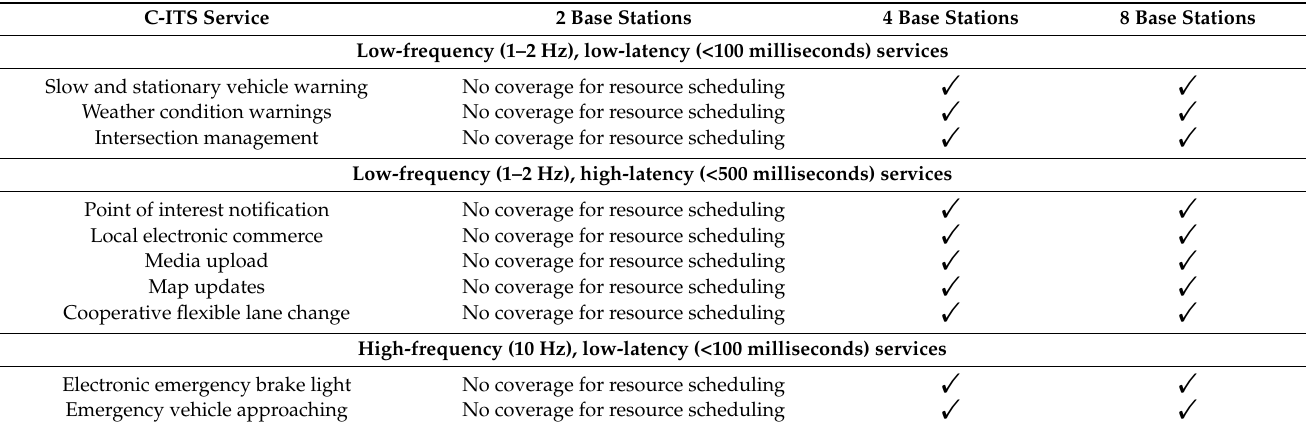
Table 8. Communication requirements of common C-ITS services and their fulfillment by 5G-based C-V2X in the D2D mode 3 and investigated context. Adapted and updated from